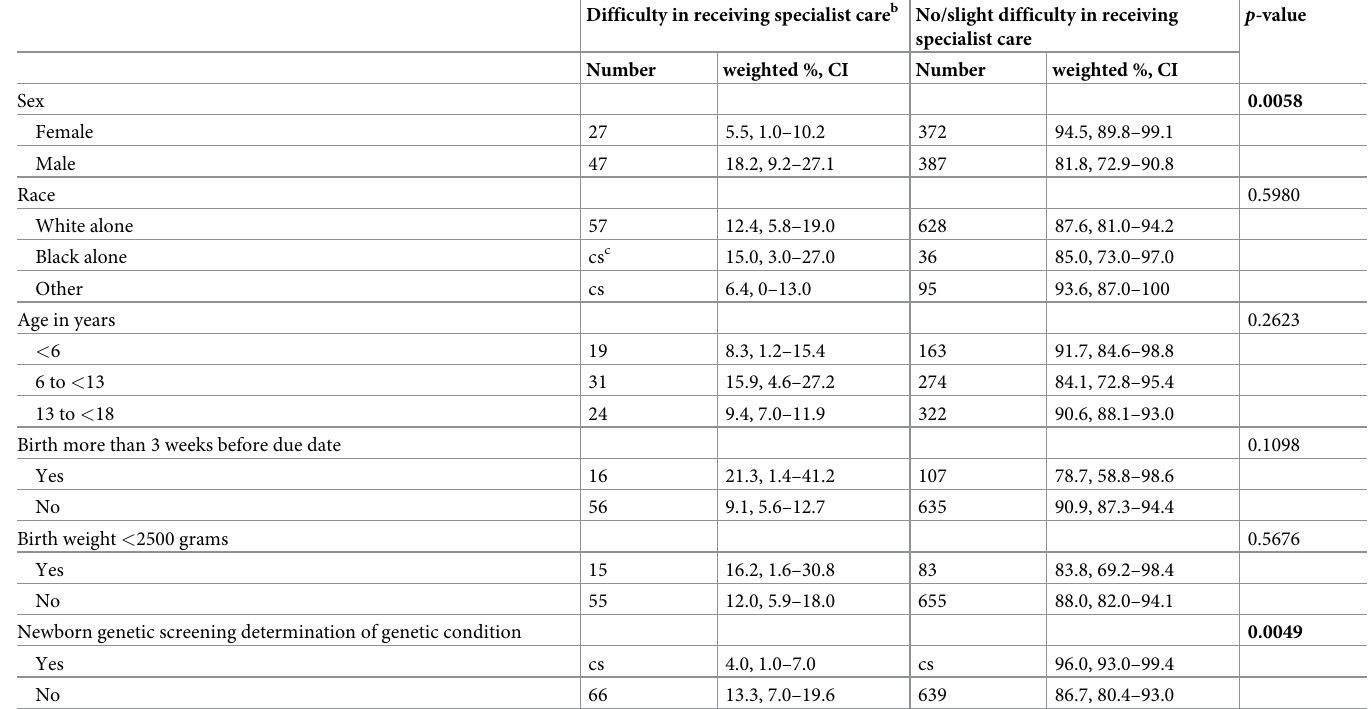
Table 2. Difficulty receiving needed specialist care among children with genetic disease/conditions vs. variables of interest, NSCH, a 2020 (n =